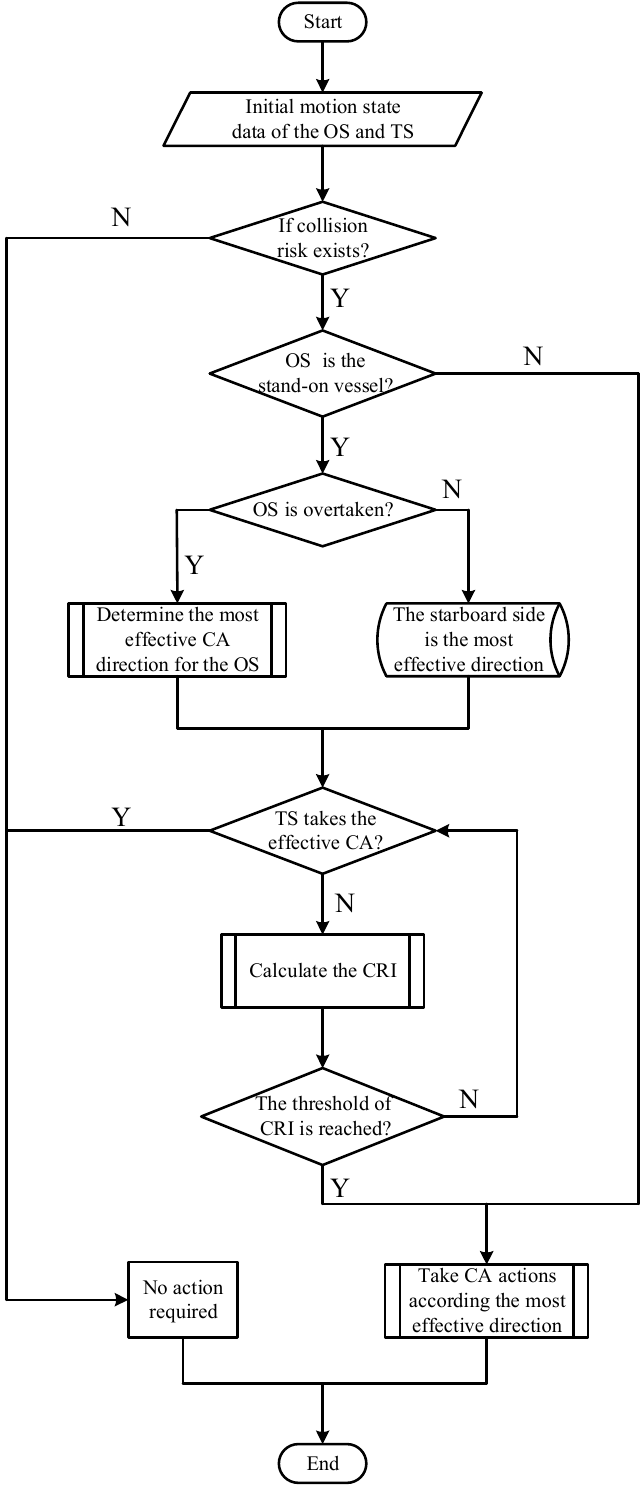
Figure 9. Flowchart of the ACA decision-making method for the stand-on vessel.